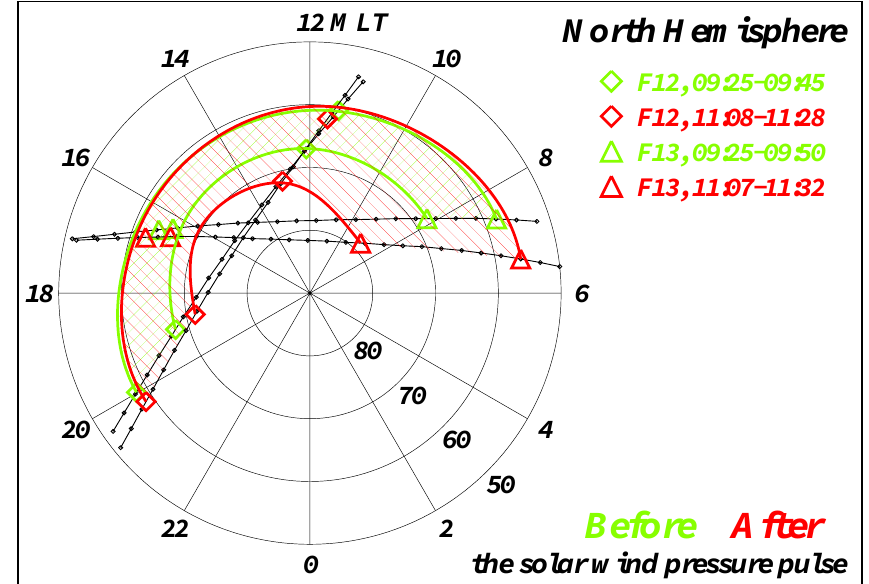
Fig. 1. Auroral boundaries for 10 January 1997, based on the individual boundary identifications from the DMSP spectrograms. The satellite orbits are shown as black lines. The tick marks on them are one minute apart. The big diamonds and triangles represent the actual boundary determinations for F12 and F13, respectively. The green and red curves are the inferred oval boundaries for before and after the arrival of the solar wind pressure front (Boudouridis et al., 2003). A closing of the polar cap is observed at all